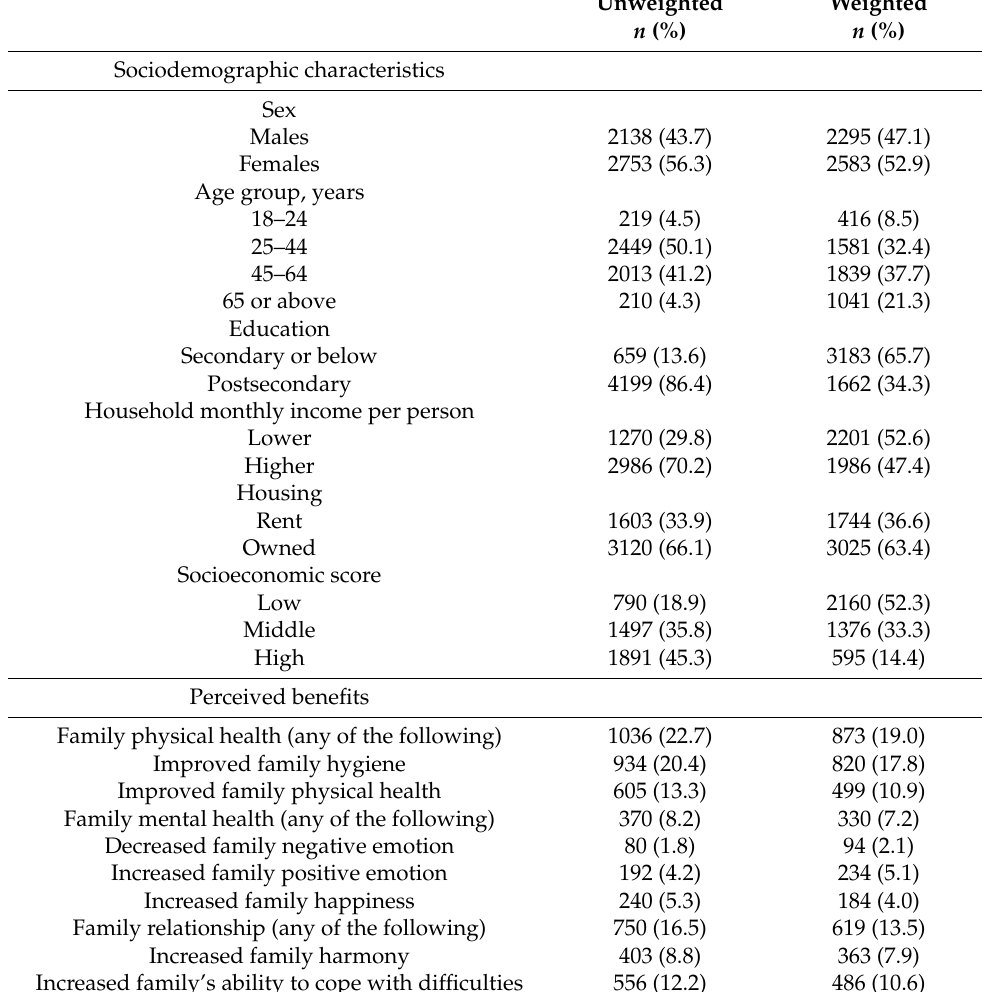
Unweighted Weighted n (%) n (%)